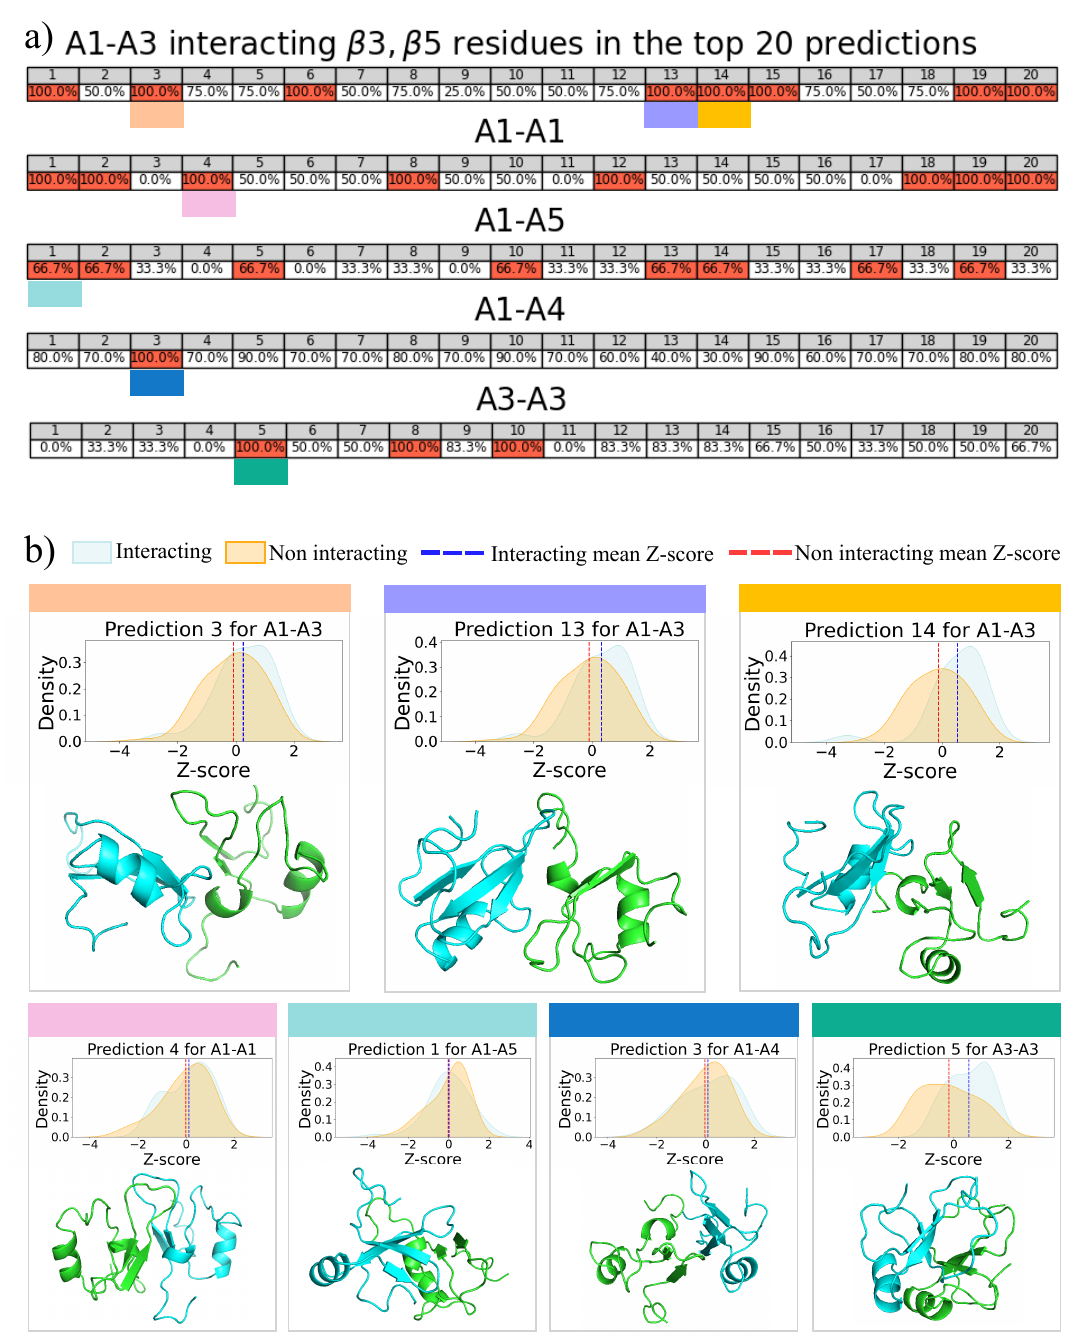
Figure 5. Analysis and selection of Fragments’ binding poses. ( a ) Percentages of β 3, β 5 residues involved in the bond over the total number of β 3, β 5 residues for the top 20 docking-predicted complexes comprising the top five Zernike-selected pairings. Predictions with the highest percentages are underlined in red, while colored boxes point out the complexes characterized by a mean Binding Propensity (BP) Z-score of the residues involved in the bond ( m B ) higher than the one computed for the non-interacting residues ( m nB ). ( b ) Probability distribution of BP Z-scores for interacting (cyan) and non-interacting (orange) residues for each prediction marked by a colored box in panel ( a ). Vertical blue and red line represent the m B and m nB values, respectively. Cartoon representation of the analyzed complexes are reported below the BP Z-score